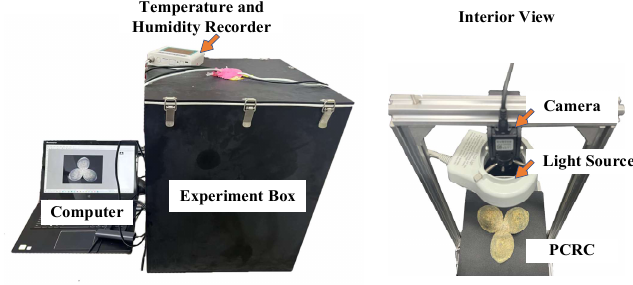
Figure 6. PCRC mildew environmental experiment box.